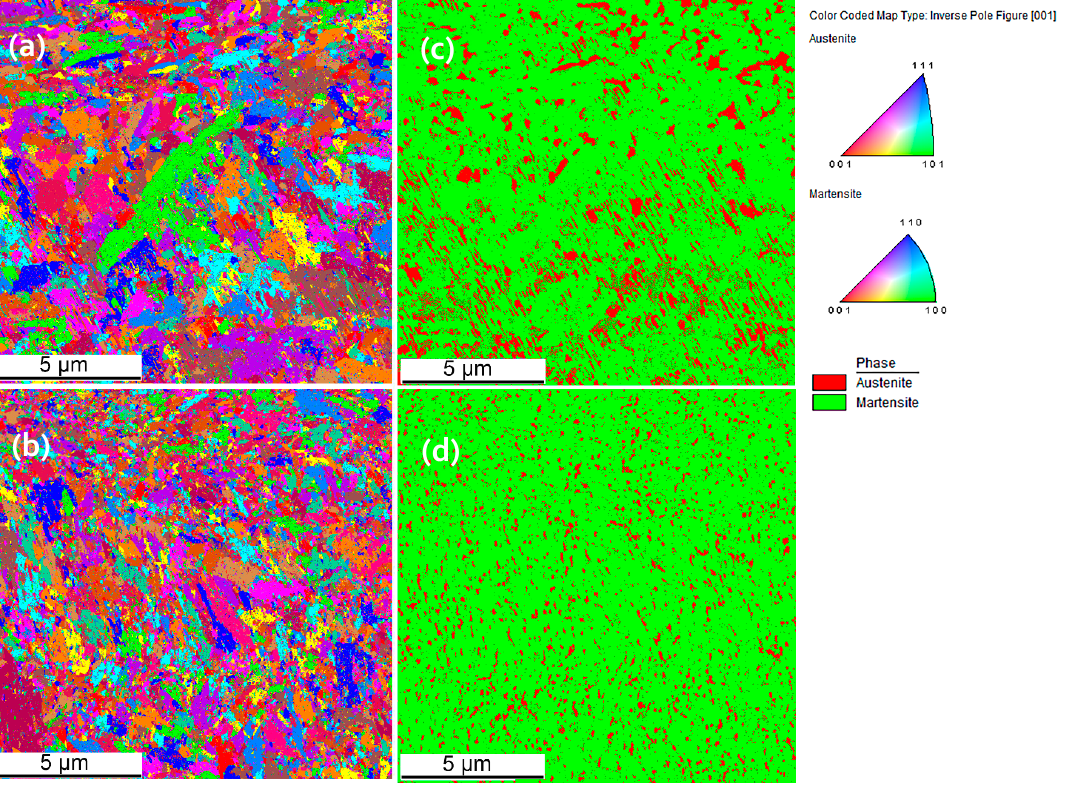
Figure 14. Electron backscatter diffraction (EBSD) grain orientation maps of the sections along the build direction: ( a ) Sample PC9 and ( b ) sample C9. Spatial distribution of phases: ( c ) Sample PC9 and ( d ) sample C9 .